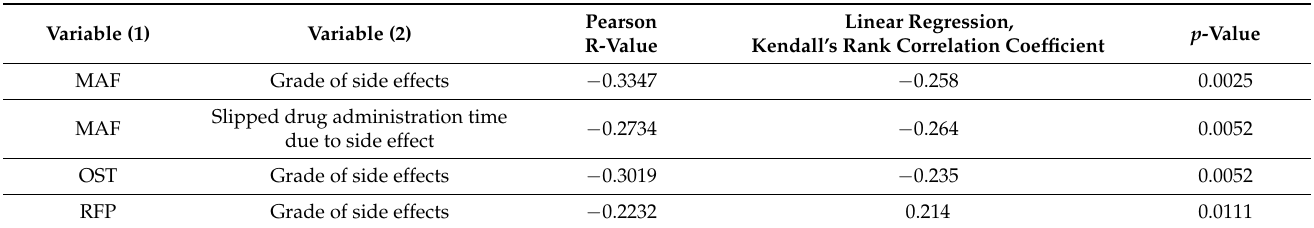
Table 7. A comparison of the grade of side effects with MAF and survival times.